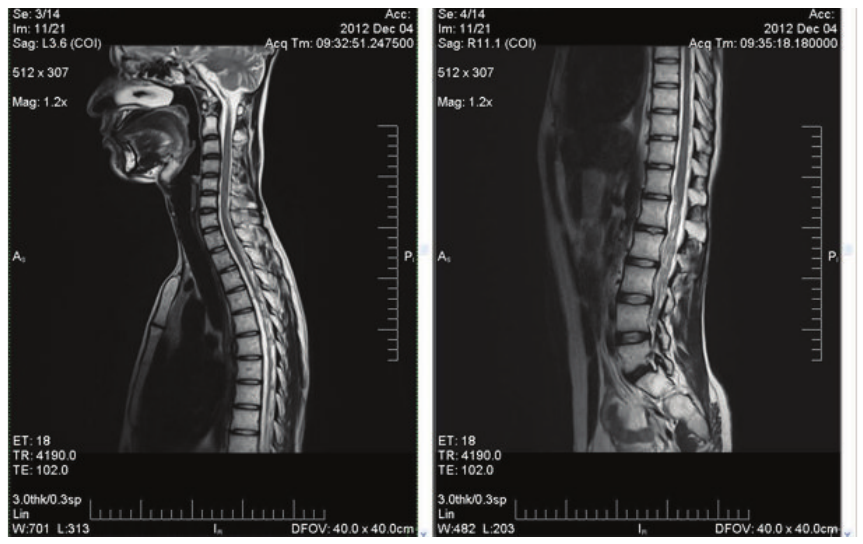
Figure 2: Pretreatment